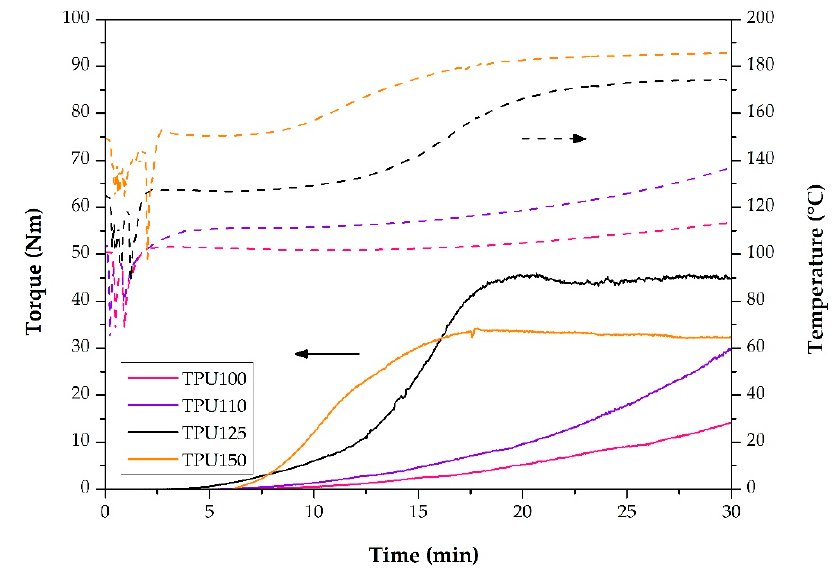
Figure 2. The parameters recorded during the synthesis of the thermoplastic polyurethanes (TPUs): torque curves (——) and temperature curves (– – ).